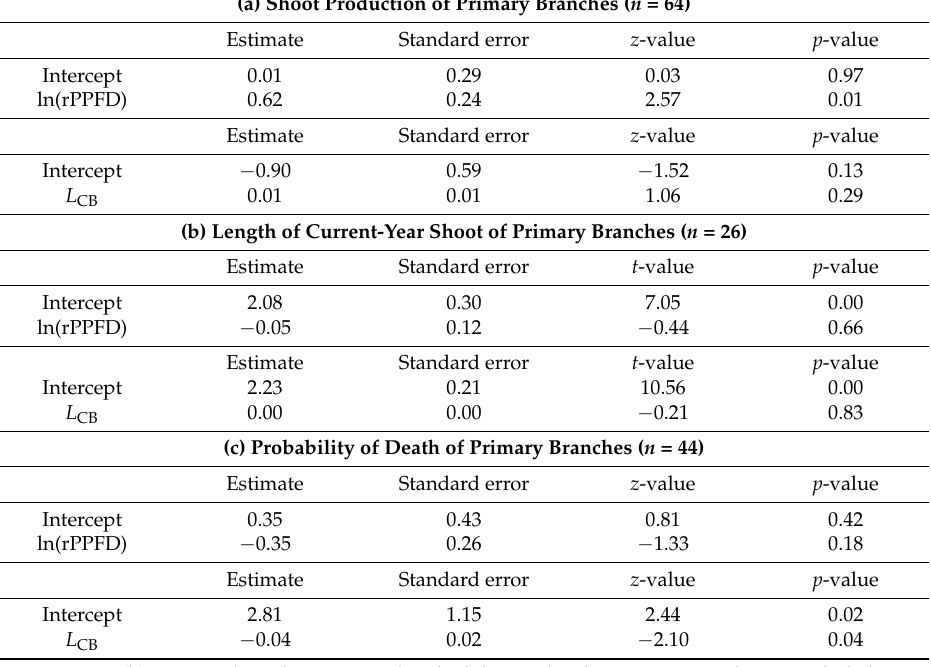
Table 1. Coefficients of the effects of relative photosynthetic photon flux density (rPPFD) (%) and the length between the basal location of a primary branch and the crown base ( L CB , cm) on ( a ) the probability ( P ) of current-year shoot production on a primary branch (see Figure 1); ( b ) the length of current-year shoots of primary branches; and ( c ) the probability ( P ) of death of primary branches (see Figure 2).